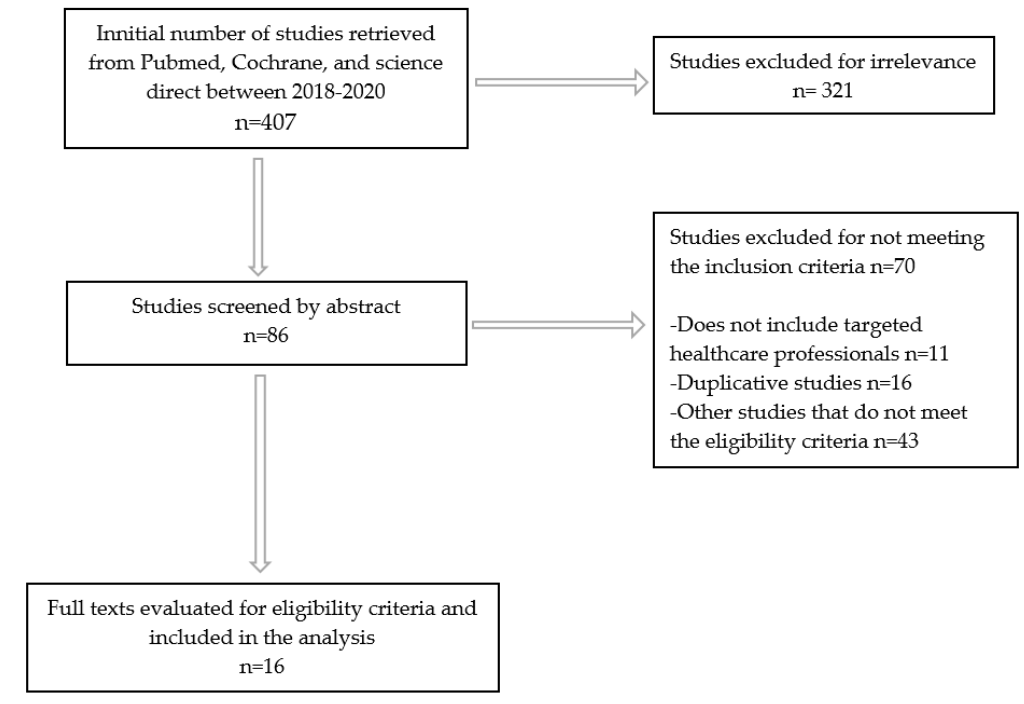
Figure 1. Flow chart of the inclusion and exclusion criteria.